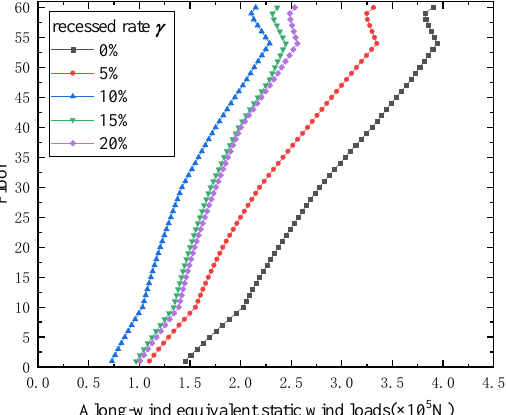
Figure 18. Along − wind equivalent static wind loads. Figure 18. Along-wind equivalent static wind